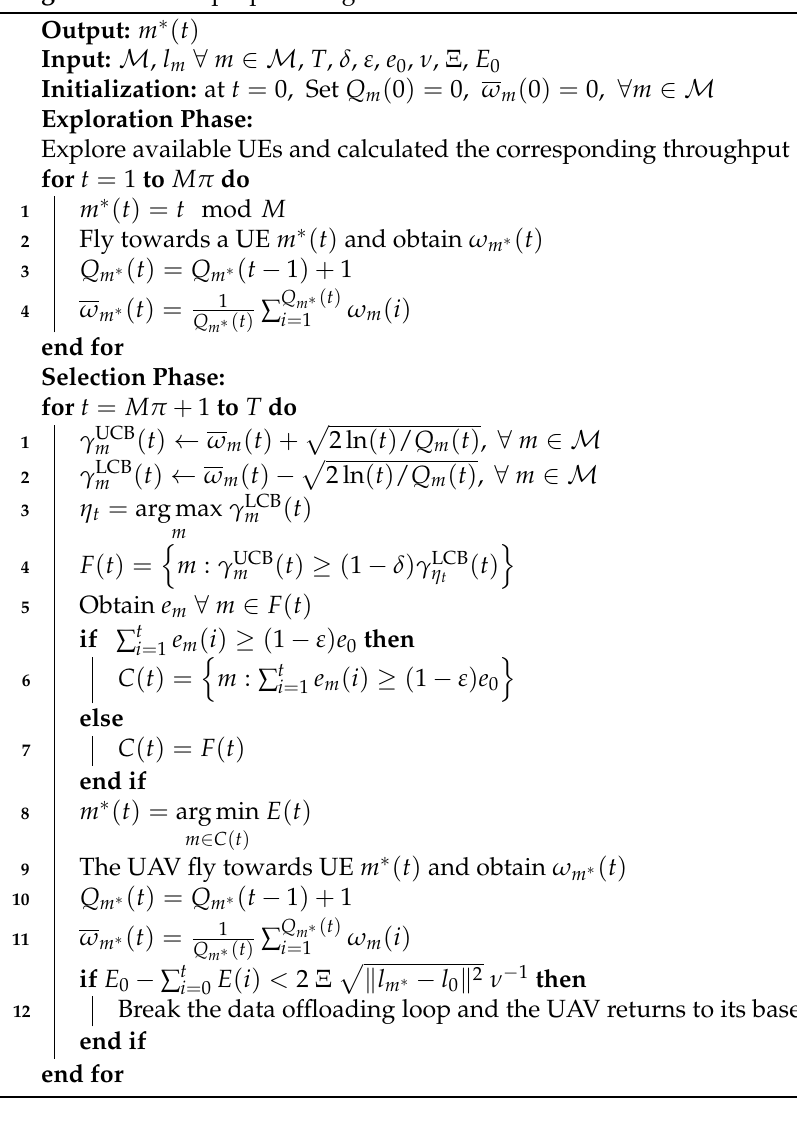
Algorithm 1: The proposed algorithm: